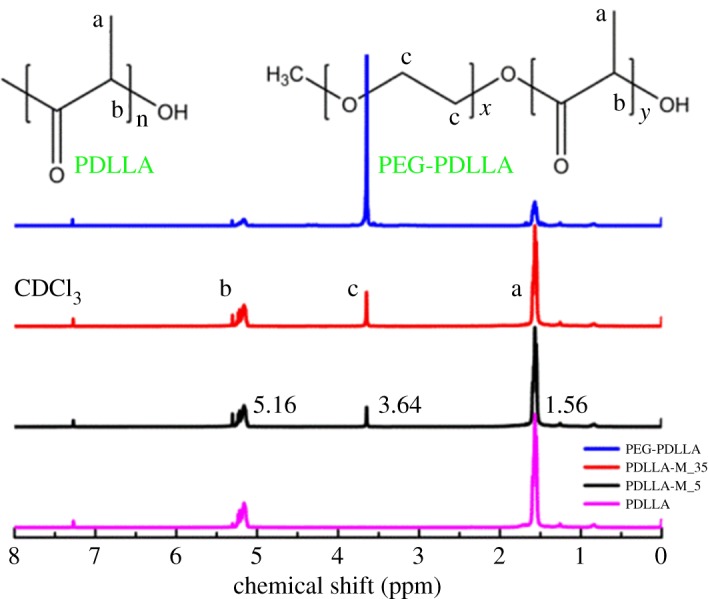
1H NMR spectra of PDLLA, PEG-PDLLA, PDLLA-M_5 and PDLLA-M_35 membrane.